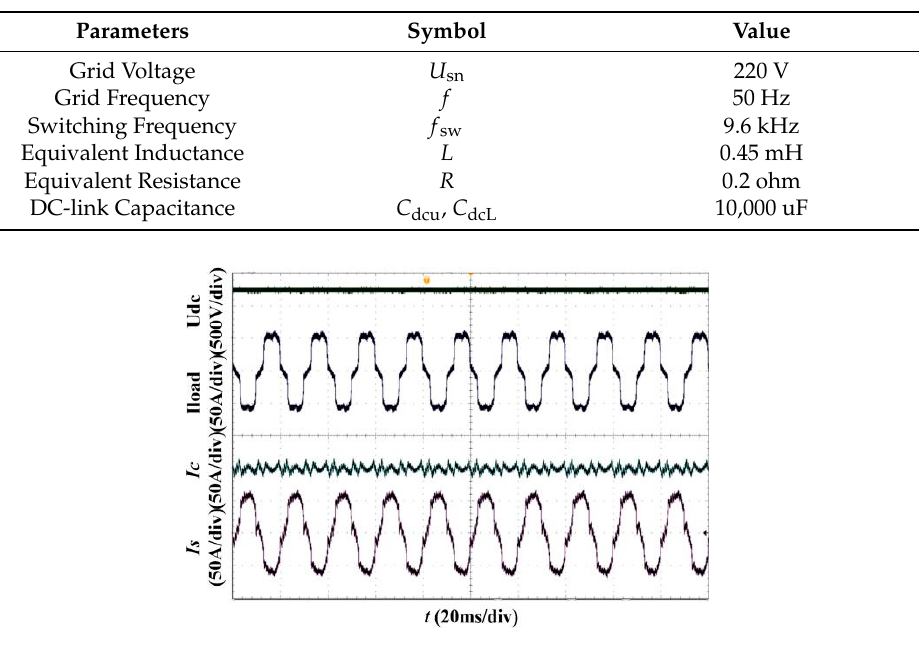
Figure 5. Voltage and current waveforms when U sn = 220 V and U dc-ref = 620 V.